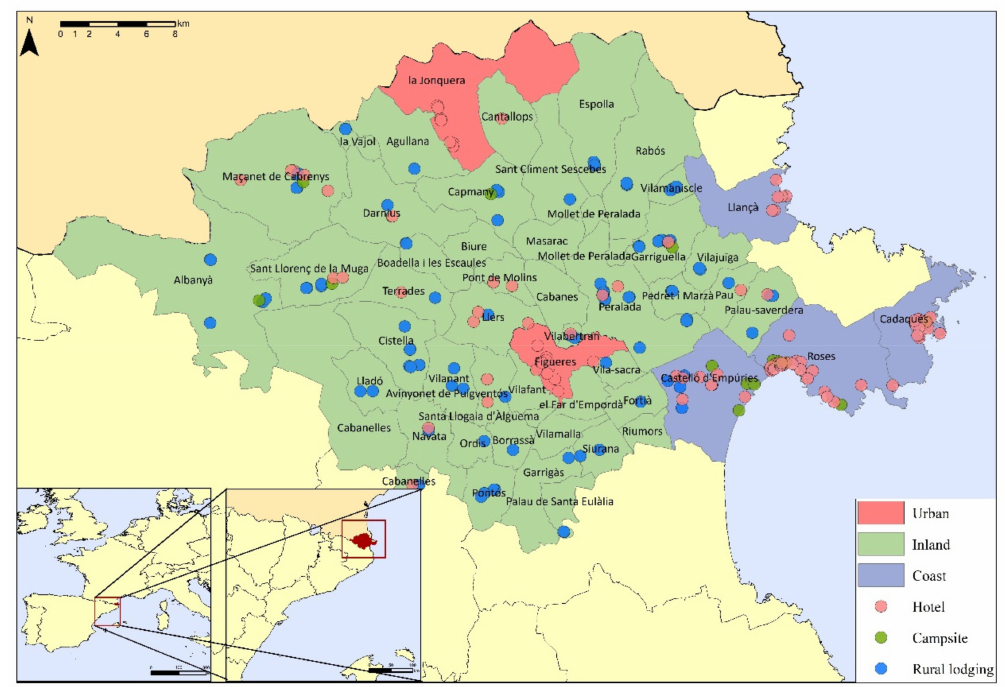
Figure 1. Location of tourist accommodation establishments in the Muga river basin by